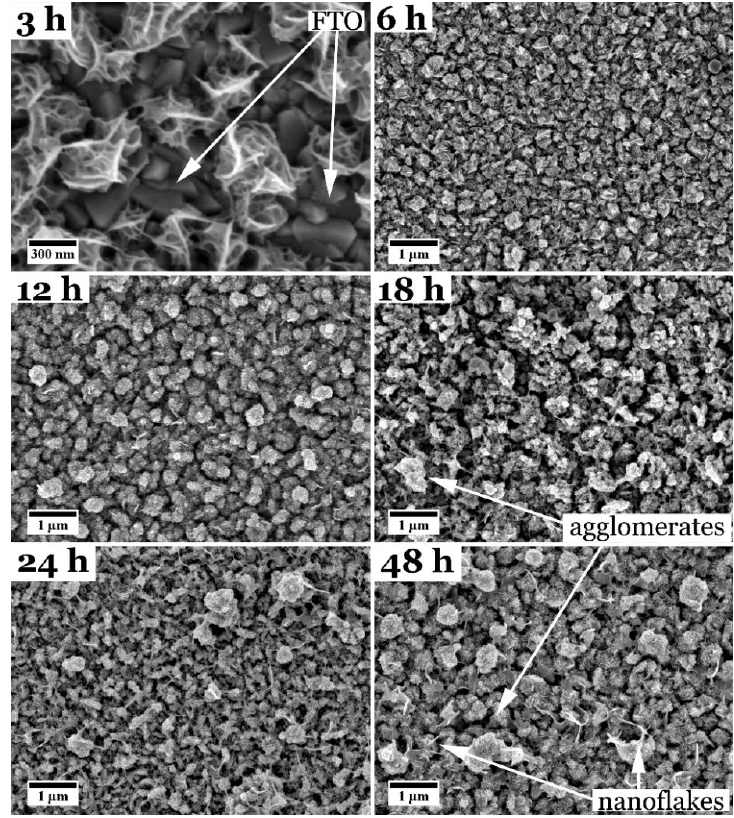
Figure 1. Top-view SEM images of CuInS 2 films synthesized with L -cysteine for different reaction times at 150 °C. The time varied between 3 h and 48 h. Please note a different scale bar for a reaction time of 3 h (film_3 h).